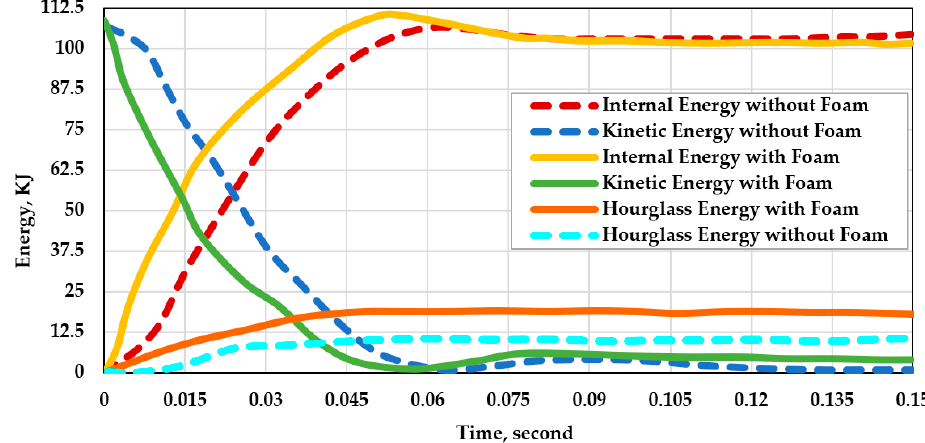
Figure 4. Numerical energy balance graph.